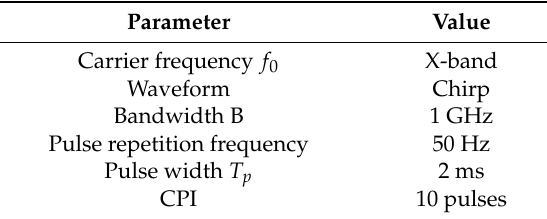
Table 3. Simulation system